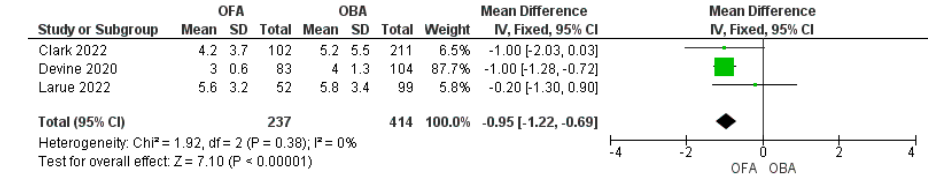
Figure 4. Forest plot of mean difference of length of stay comparing opioid − free anesthesia and